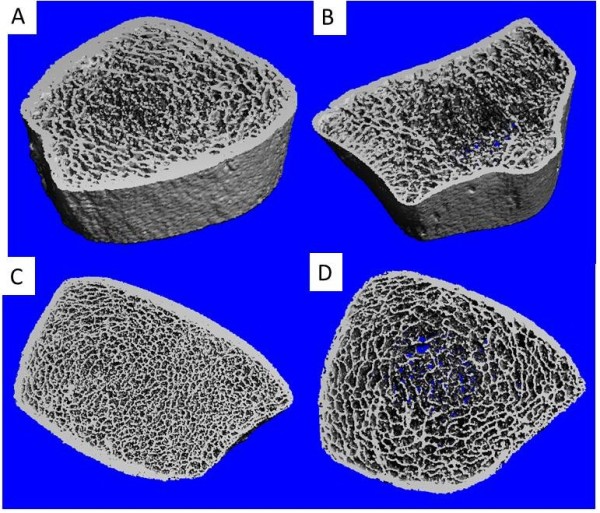
HRpQCT images of ultradistal radius and tibia. (A) 3D representation of ultradistal tibia. AS patient with normal BMD. (B) 3D representation of ultradistal radius. AS patient with osteoporosis. (C) 2D representation of ultradistal tibia. AS patient with normal BMD. (D) 2D representation of ultradistal tibia. AS patients with lumbar osteoporosis. Note the low trabecular number and thickness, high trabecular separation, and low cortical thickness.